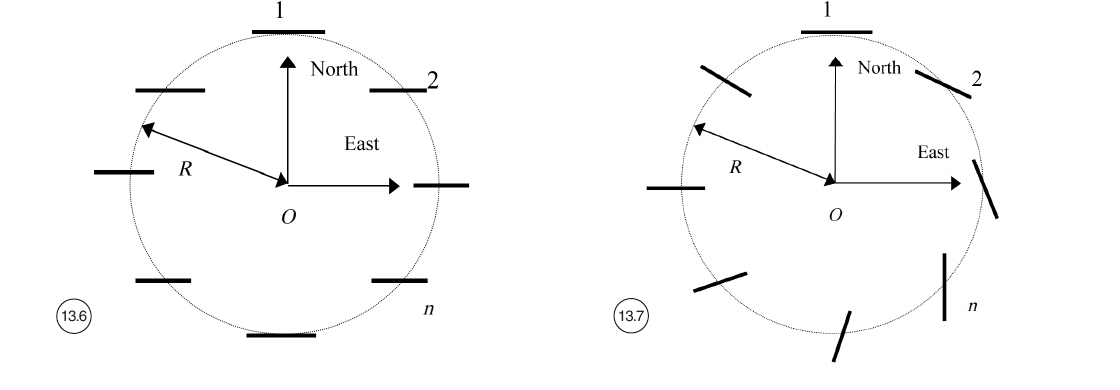
Fig. 13.6. Homogeneous circular array. Fig. 13.7. Heterogeneous circular